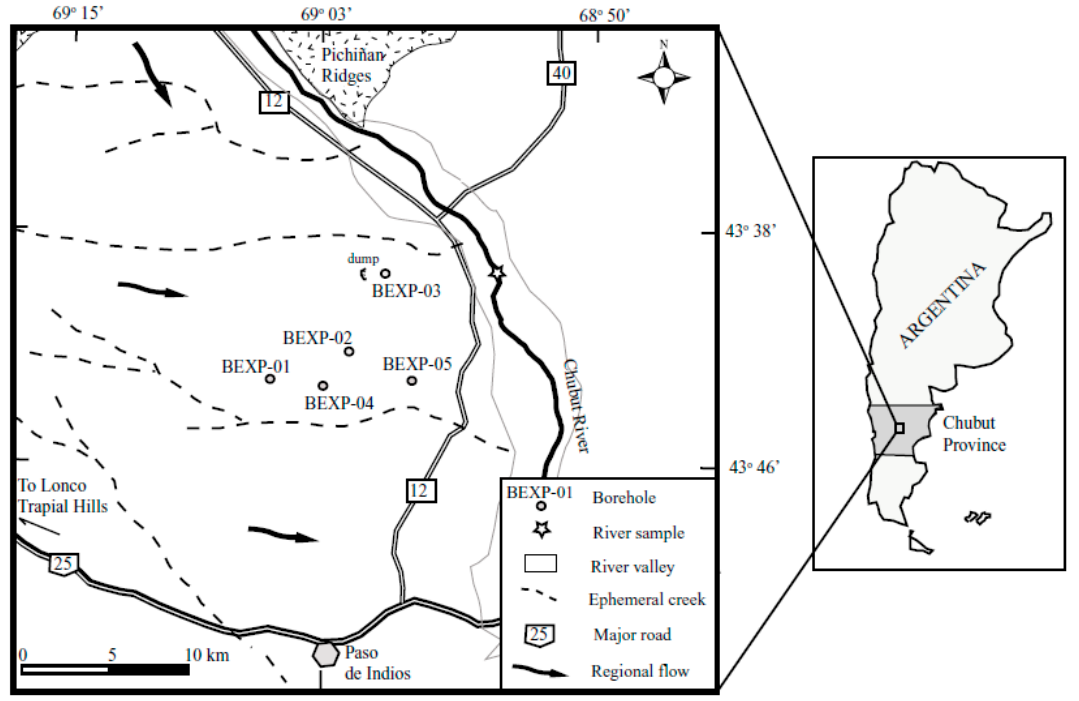
Figure 1. Location of the study area.